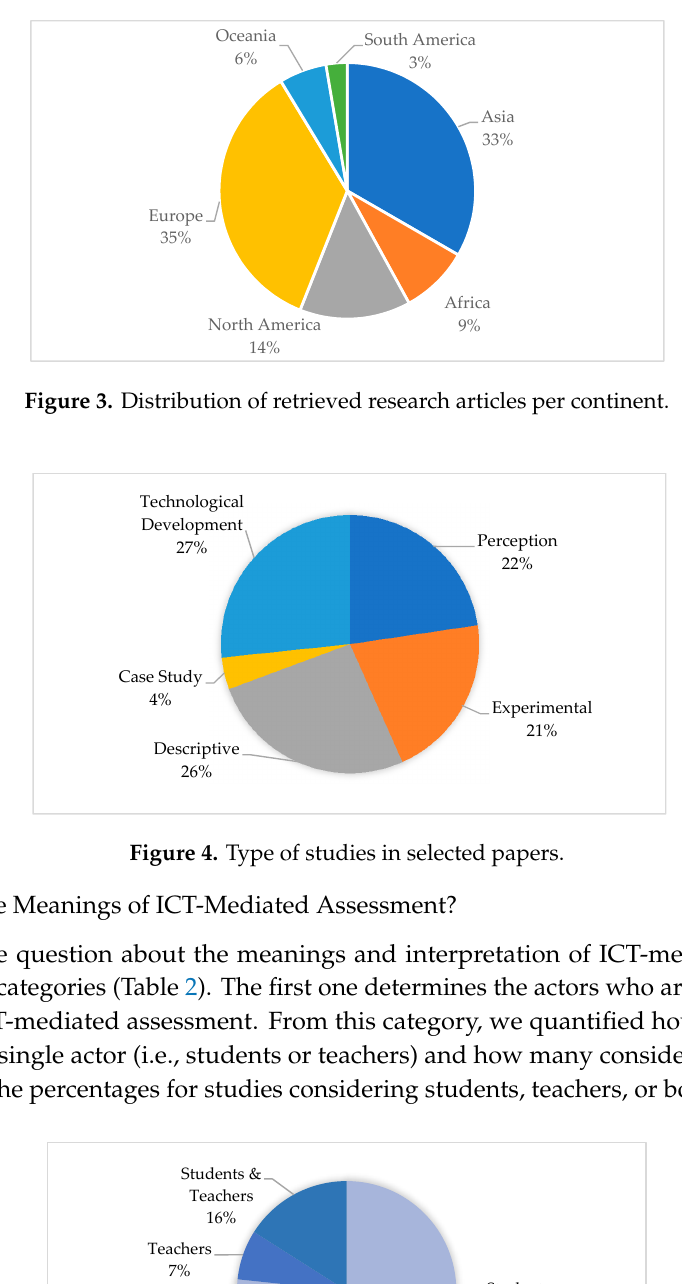
Figure 2. Number of selected research articles per year of publication.